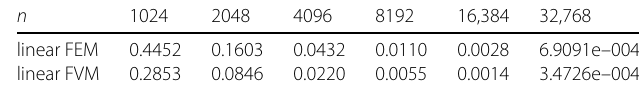
Table 12 The error in the relative discrete H 1 -seminorm for problem (5.2) with k = 300 n